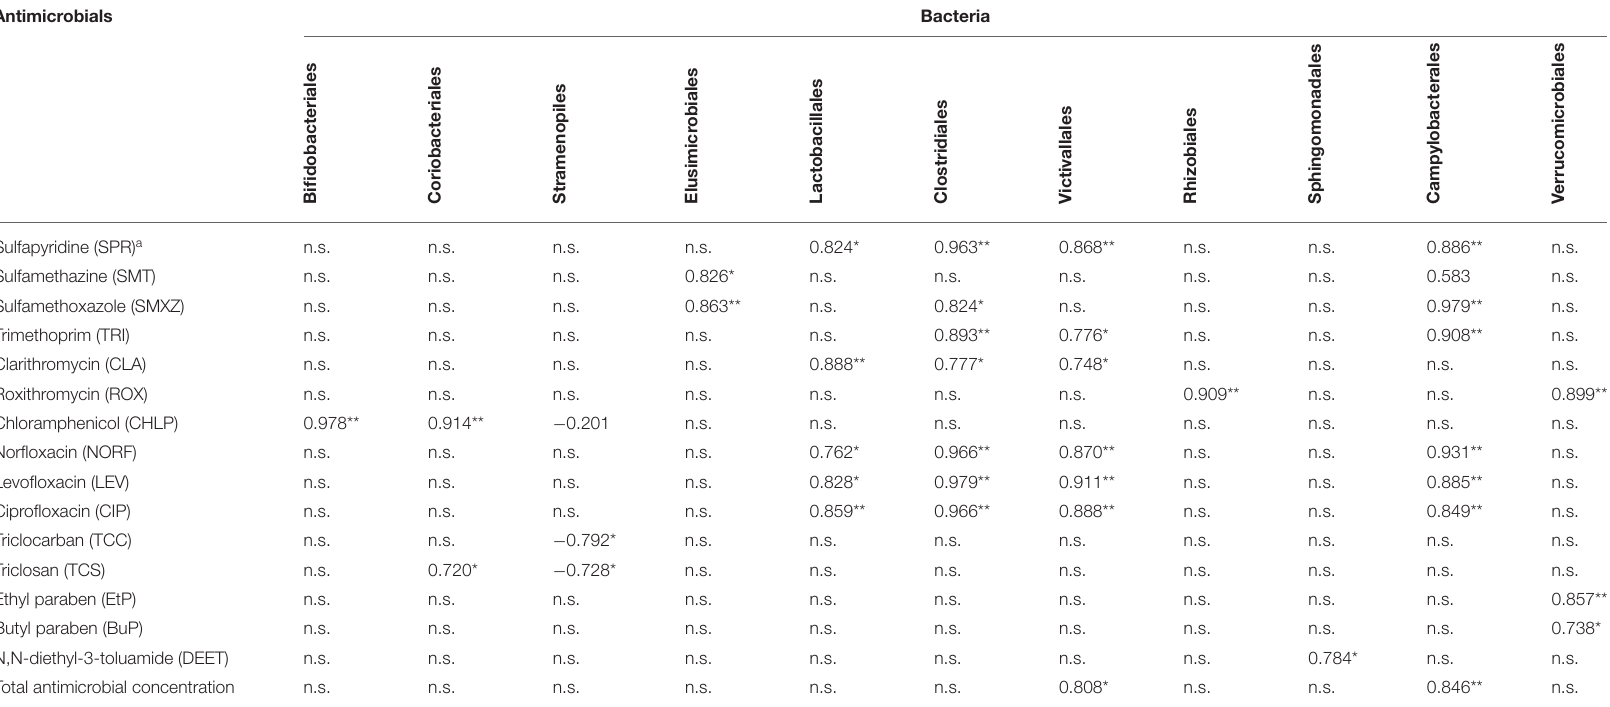
TABLE 2 | Correlations between relative abundance of bacteria (Order level) and concentrations (ng/L) of antimicrobials a in SL1–SL 8 samples. Antimicrobials